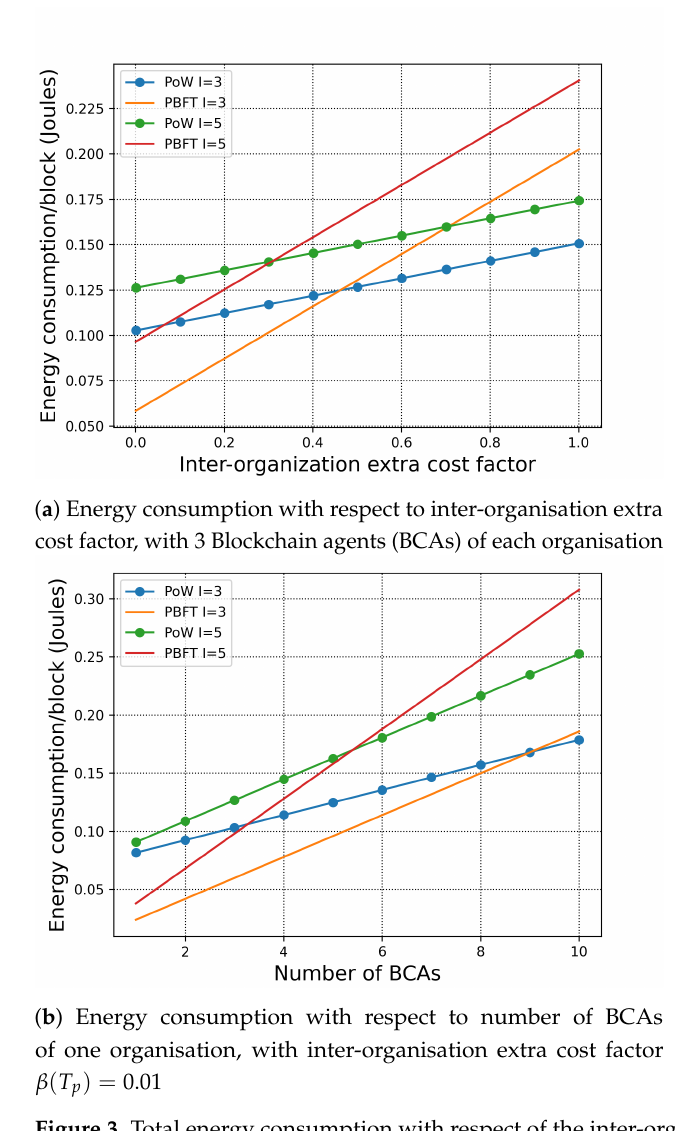
Figure 3. Total energy consumption with respect of the inter-organisation extra cost factor and the number of BCAs. γ ∗ : γ (cid:48) = 100 : 1, D = 2, K =